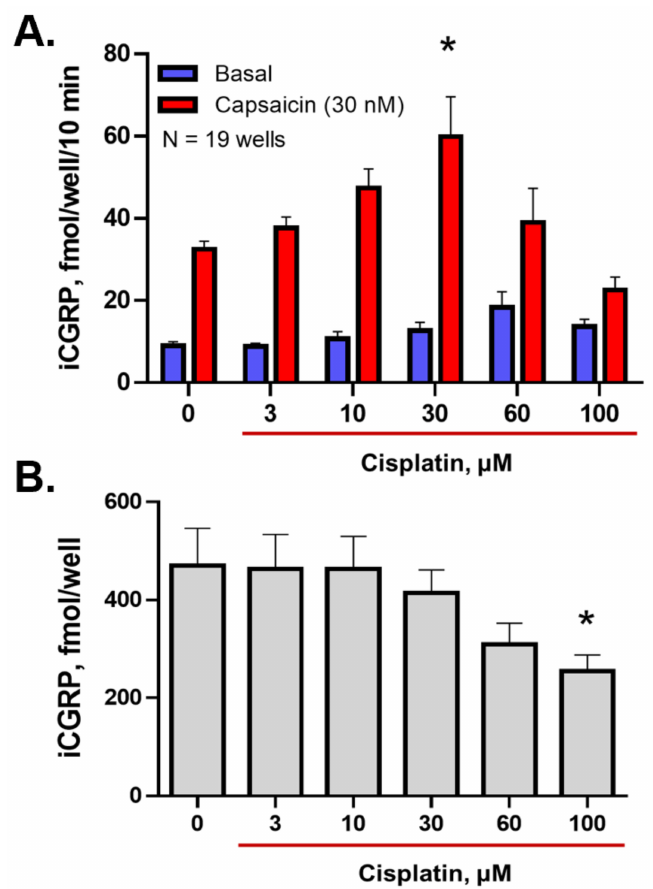
Figure 1. CGRP release from neuronal cultures is altered following exposure to cisplatin. ( A ). Columns represent the mean ± SEM of CGRP release stimulated by a 10 min exposure to 30 nM capsaicin following a 24 h exposure to increasing concentrations of cisplatin (30 µ M). * p < 0.0001 comparing stimulated release in CIS to no treatment control, two-way ANOVA with Tukey’s posttest. ( B ). Each column represents the mean ± SEM of the total CGRP content following exposure to cisplatin treatments. * p < 0.05 comparing content in CIS (100 µ M) to no treatment control, one-way ANOVA with Dunnett’s